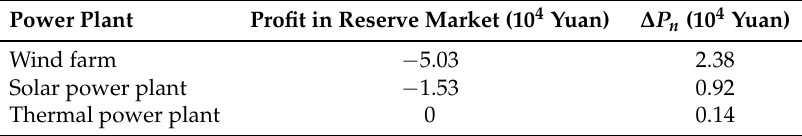
Table 6. Profit of power producers in the reserve market.